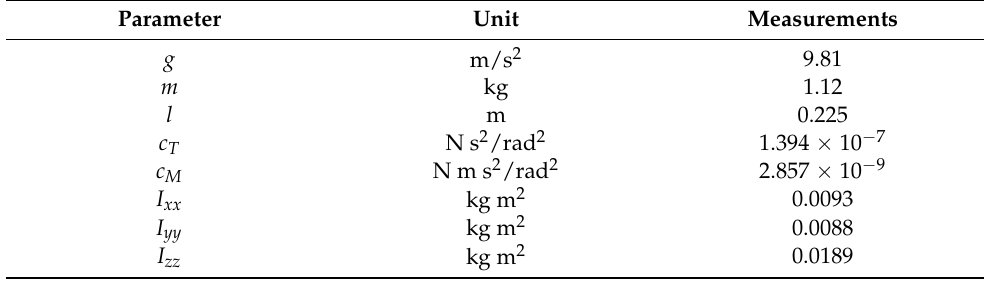
Table 1. Parameter list of the